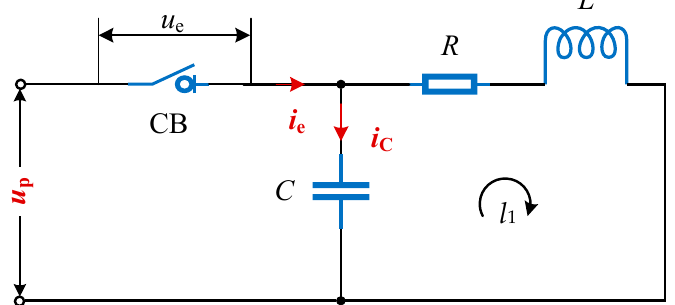
highly connected with the supply voltage and power factor. After introducing the arc voltage, changes of arc current under different supply voltages and power factors and the influence on the CEA can be obtained. The specific analysis process is given below. Using a single-pole contact as an example, Figure 3 shows the equivalent circuit diagram of a contact-breaking load circuit. Among them, R and L are load-side resistance and inductance, which can be used to adjust the circuit power factor. C is the capacitance to the ground, and the current flowing through C is usually minimal, and its current value can be ignored. u p and u e are the supply voltage and arc voltage, respectively.